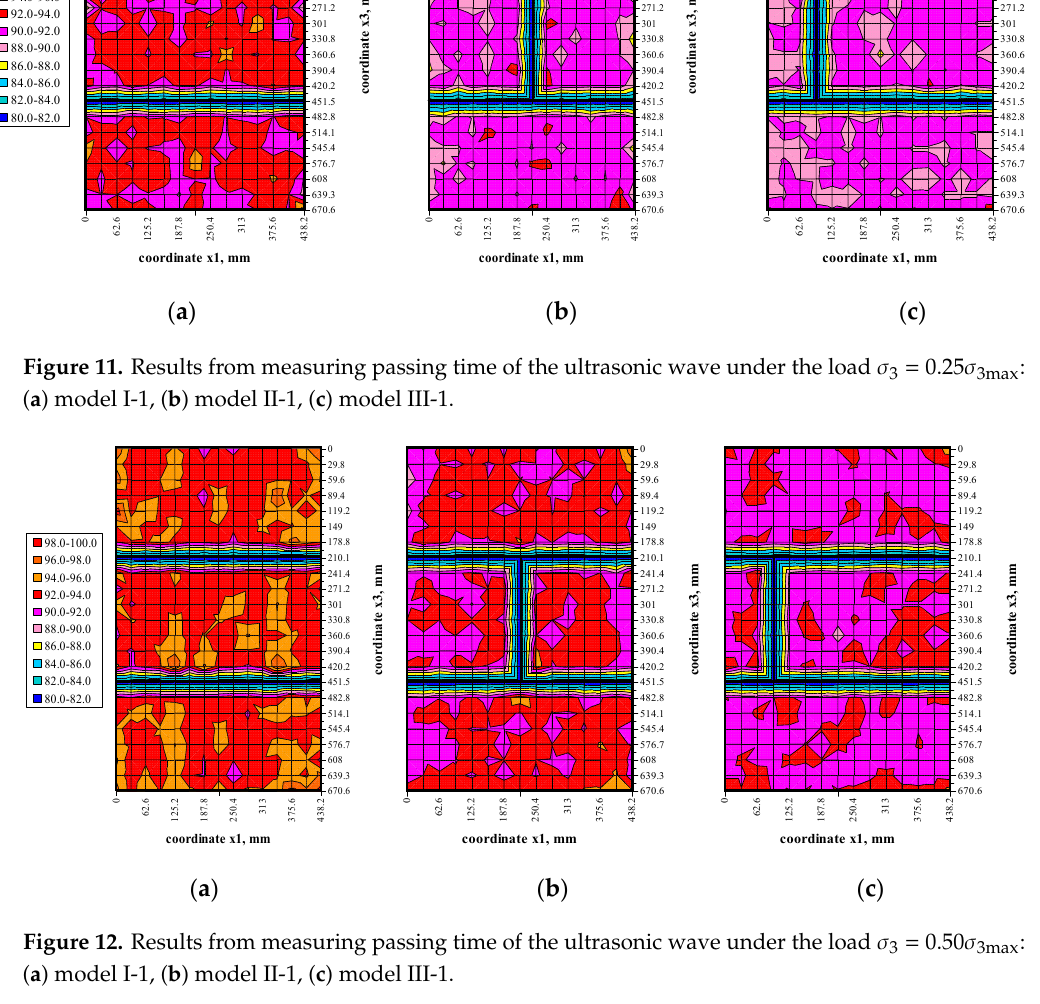
Figure 12. Results from measuring passing time of the ultrasonic wave under the load σ 3 = 0.50 σ 3max : ( a ) model I-1, ( b ) model II-1, ( c ) model III-1.